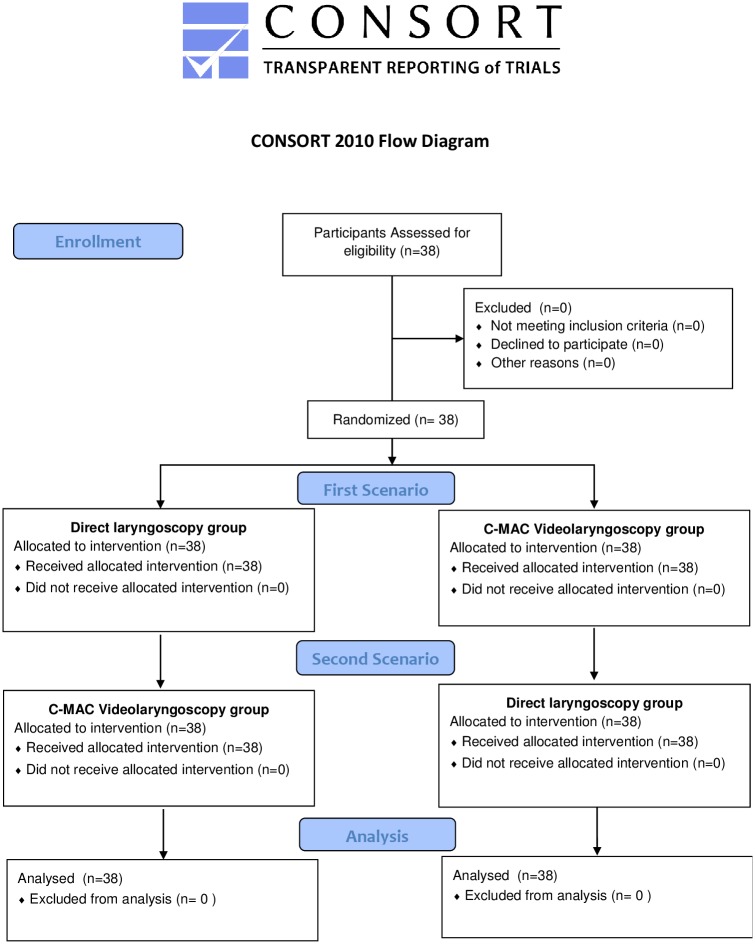
CONSORT Diagram.